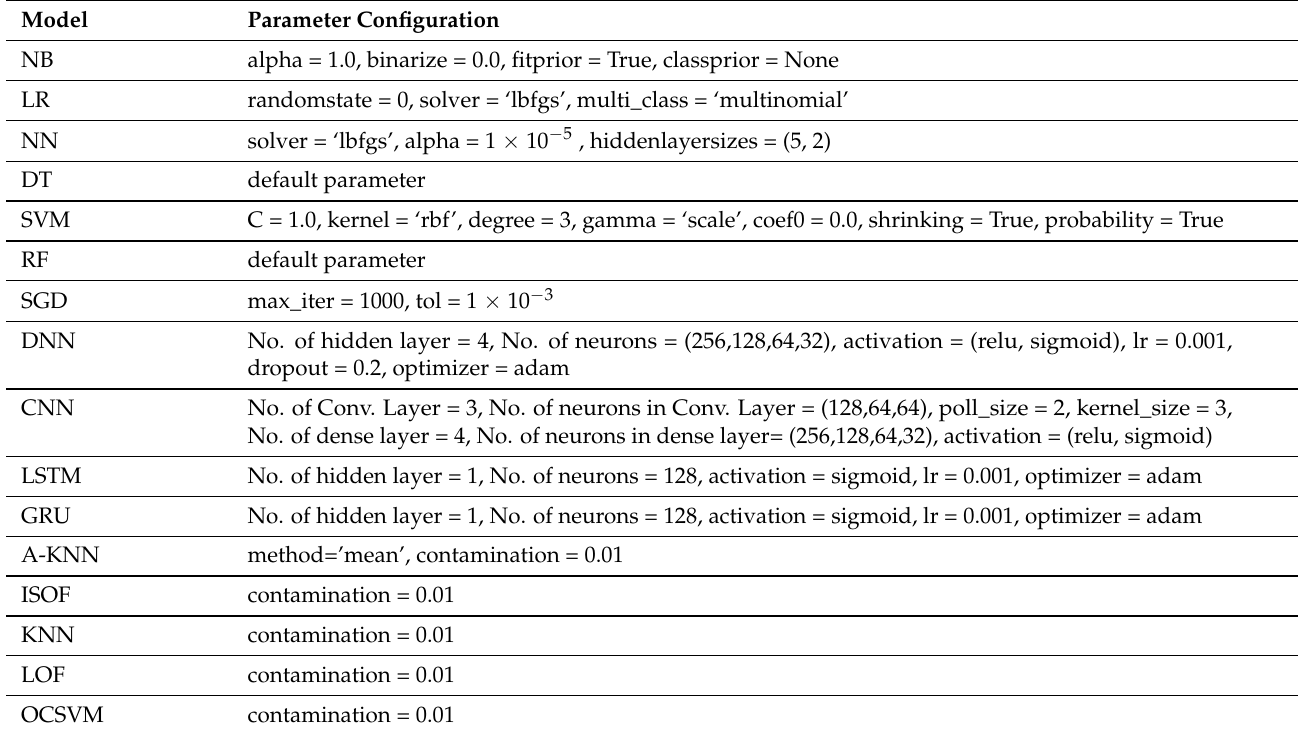
Table 3. Hyper-parameters setting for classification models.